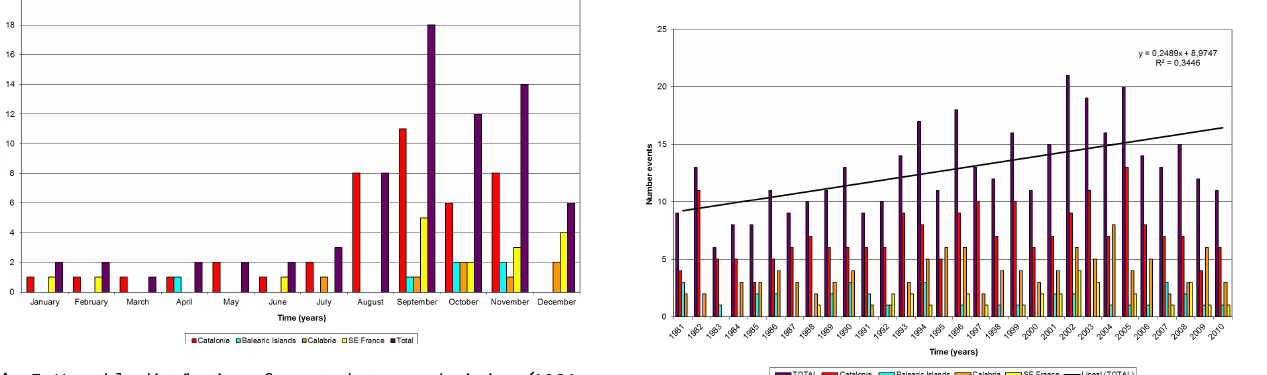
Fig. 5. Monthly distribution of events that caused victims (1981– 2010).